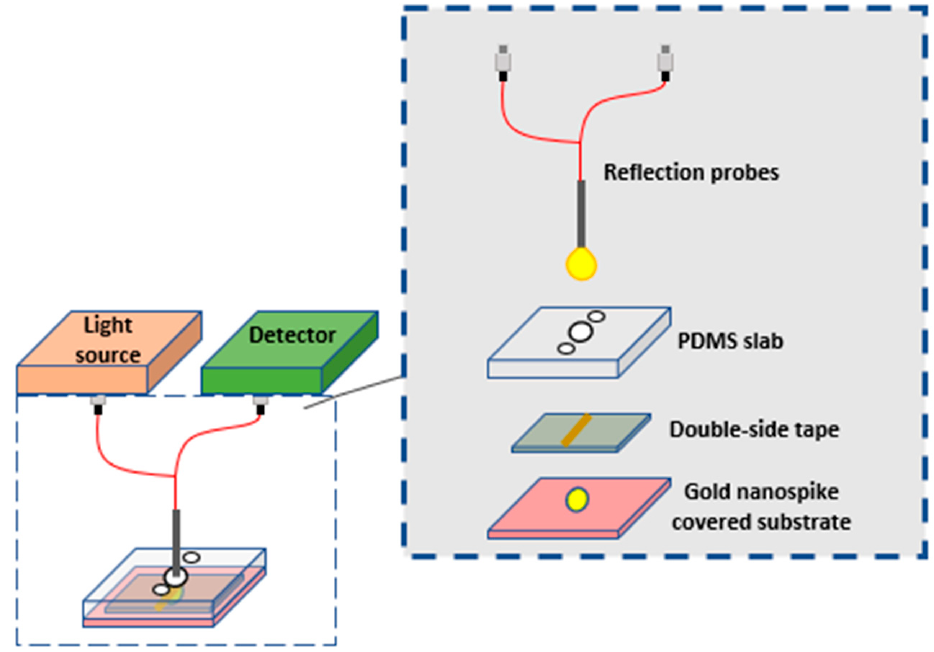
Figure 5. Schematic diagram of the composition of the integrated optofluidic device where the light source gives light to the reflective fiber optic probe to excite the gold nanospikes implanted in the opto-microfluidic chip. The probe also gathers the reflected light back to the detector. In 2017, a hybrid nanostructure of Au NP and magnetic NP decorated graphene (MNP-GRP) was designed to target and bind to norovirus-like particles (NVLP). Binding of the virus at concentrations ranging from 0.01 pg/mL to 1 ng/mL with the NVLP antibody functionalized on the Au/MNP-GRP nanostructure was detected with LOD of 1.16 pg/mL [74]. In the same year, Au NPs in the form of a hetero-assembled sandwich were used to detect hepatitis B surface antigens (HBsAg) by functionalizing the antibody for HBsAg on the Au NP. The biosensor showed high specificity and the LOD was measured at 100 fg/mL [75]. Two years later, another work showed Au NP used to detect noroviral protein and human norovirus. Instead of using expensive antibodies, norovirus recognizing affinity peptides were used to detect the noroviral capsid proteins and showed LOD of 0.1 ng/mL for the noroviral protein and 9.9 copies/mL for the human norovirus [76]. Also, in 2019, LSPR for Au spike-like NPs was used for detecting AIV. This technique included detecting the virus with multi-functional DNA three-way-junction having the NPs, hemagglutinin binding aptamer, and thiol group. LOD in both surroundings, PBS buffer, and diluted chicken serum, was 1 pM [77]. Similarly, a biosensor made of thermally annealed Ag film deposited onto a silicon substrate with anti-nonstructural protein 1 (NS1) antibody was used to detect NS1 antigen of dengue virus from whole blood. The inlet of the biosensor had a filtering membrane made of polyethersulfone to separate the blood cells from the plasma. At 50 g/mL concentration, there was a 108 nm red shift in peak absorption wavelength, 9 nm sensitivity of LSPR, and LOD of 0.06 g/mL [78]. In 2020, two-dimensional Au nanostructures having octupolar geometry function- alized with rotavirus capsid (2B4) antibody were used for detecting and capturing low concentrations of rotavirus in water. For 105 PFU/mL of virus concentration, there was an LSPR wavelength shift of 46 nm and a LOD of 126 ± 3 PFU/mL [79]. In the same year, upon searching for a faster detection method for the more recent variant of the coronavirus, SARS-CoV-2, an experiment was done to detect the virus using a plasmonic